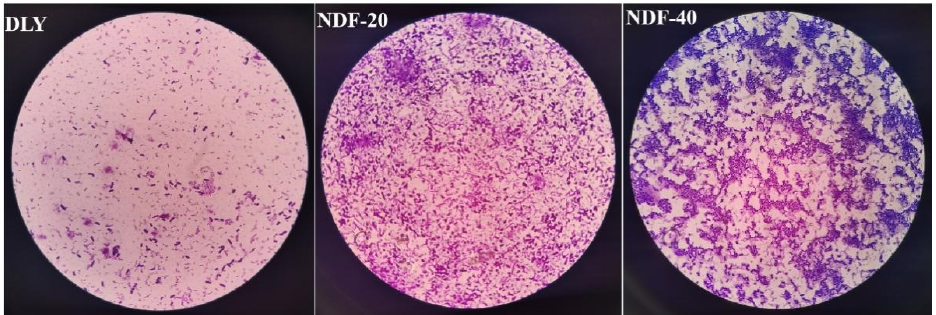
Figure 3. Microscopic observation (400×) on fecal microorganisms of DLY and Diqing Tibetan pigs by crystal violet staining.